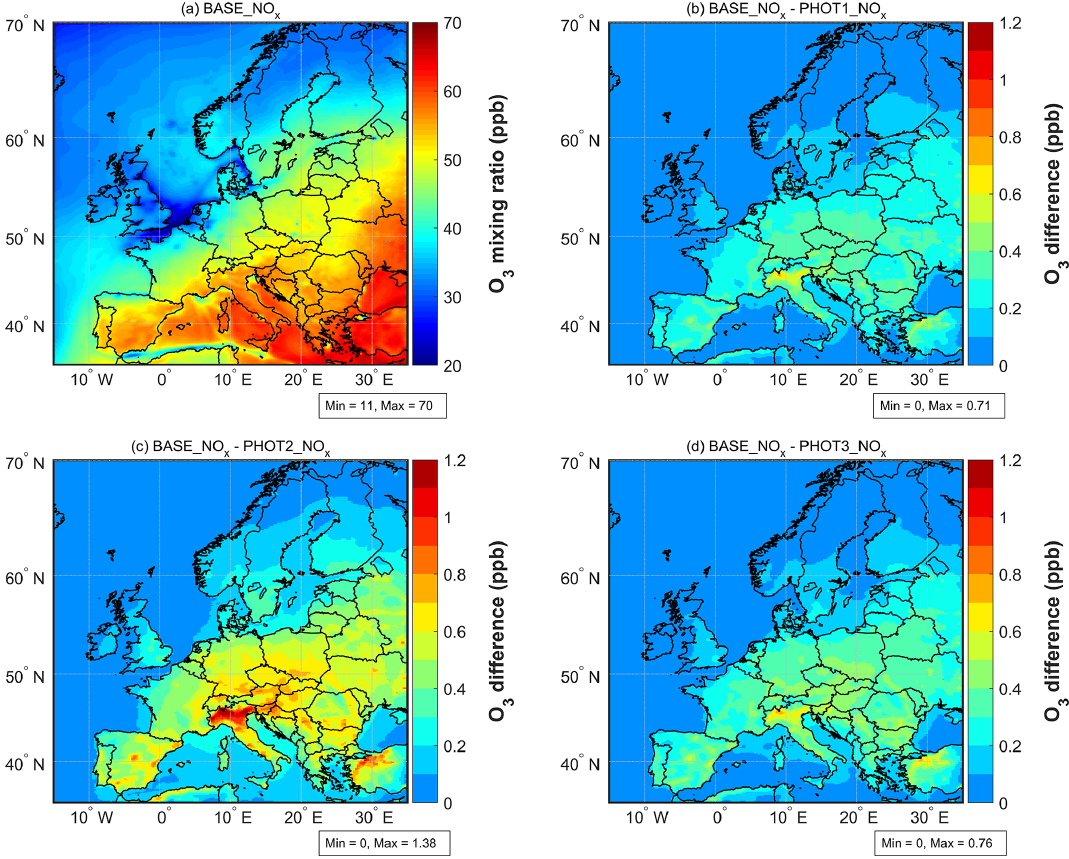
Figure 8. Seasonal daytime (10:00–18:00LMT) mean O 3 mixing ratios for the BASE_NO x scenario (a) and O 3 differences between the BASE_NO x scenario and the PHOT1_NO x , PHOT2_NO x and PHOT3_NO x scenarios (b–d) , respectively, in summer 2010. Note the different color scale between panel (a) and panels (b–d)